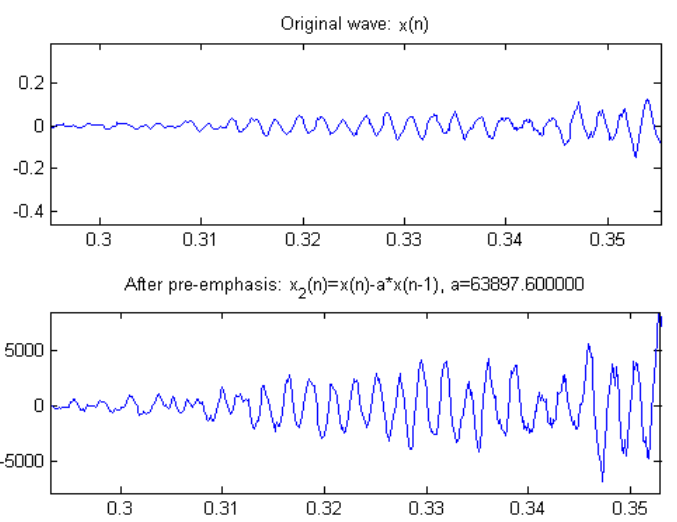
Figure 11. The typical pre-emphasis